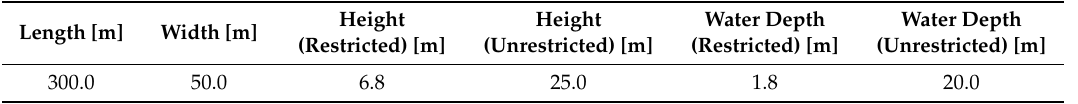
Table 2. Dimensions of the hexahedral calculation